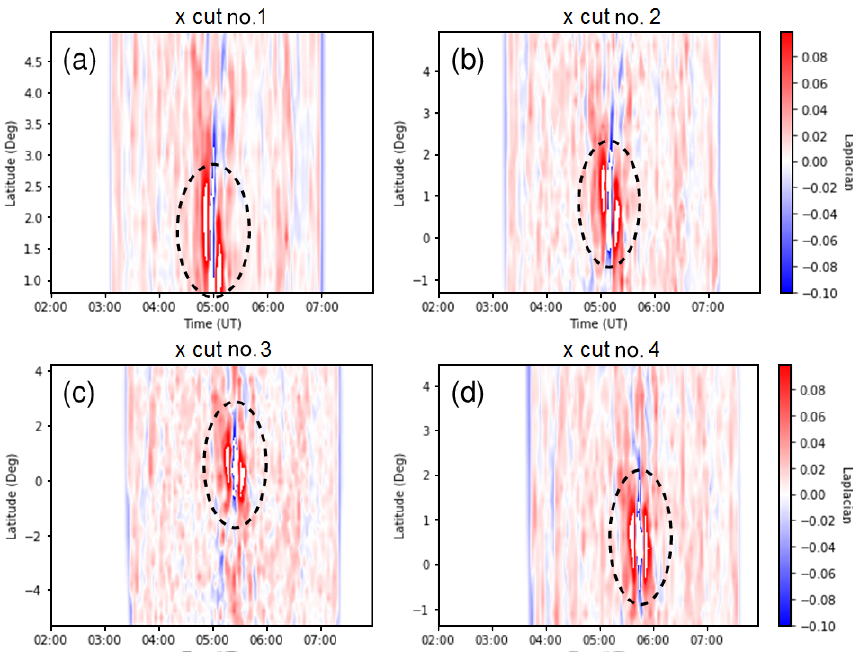
Figure 18. (a–d) Contour/color-map plot of the Laplacian of the solar EUV irradiance level at 100km altitude as a function of time and latitude along x-cut nos. 1 to 4, within a magnified time interval around the solar eclipse on 26 December 2019. Dashed circles highlight the characteristic pairs of pod-shaped blob patterns that appear in the vicinity of the annularity